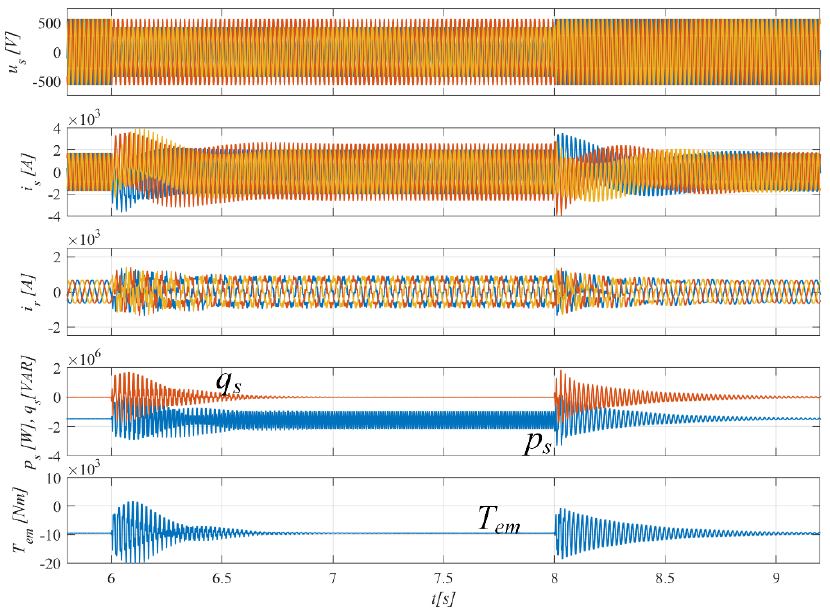
Figure 12. Simulation results of simple DPC in case of asymmetrical grid voltage transients without the feedforward and decoupling mechanism and without included rotor current information in control. Constant speed operation, Q sref = 0, T emref = − 12.7 kNm.